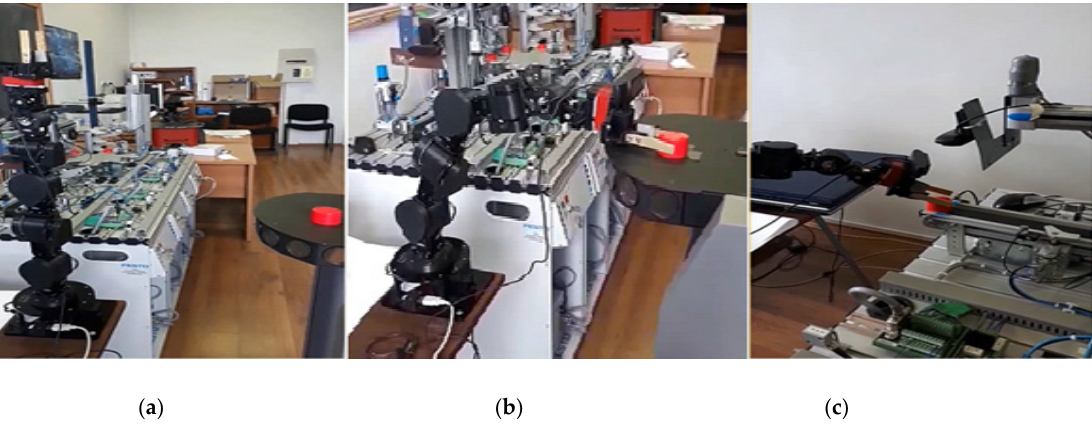
Figure 20. Real-time control of RM Cyton based on inverse kinematics for handling the work-piece: ( a ) initial position; ( b ) caching the work-piece from ARS PeopleBot; ( c ) releasing the work-piece on P/RML. Eye in hand VSS and eye to hand VSS 2 as actuators for precise positioning.